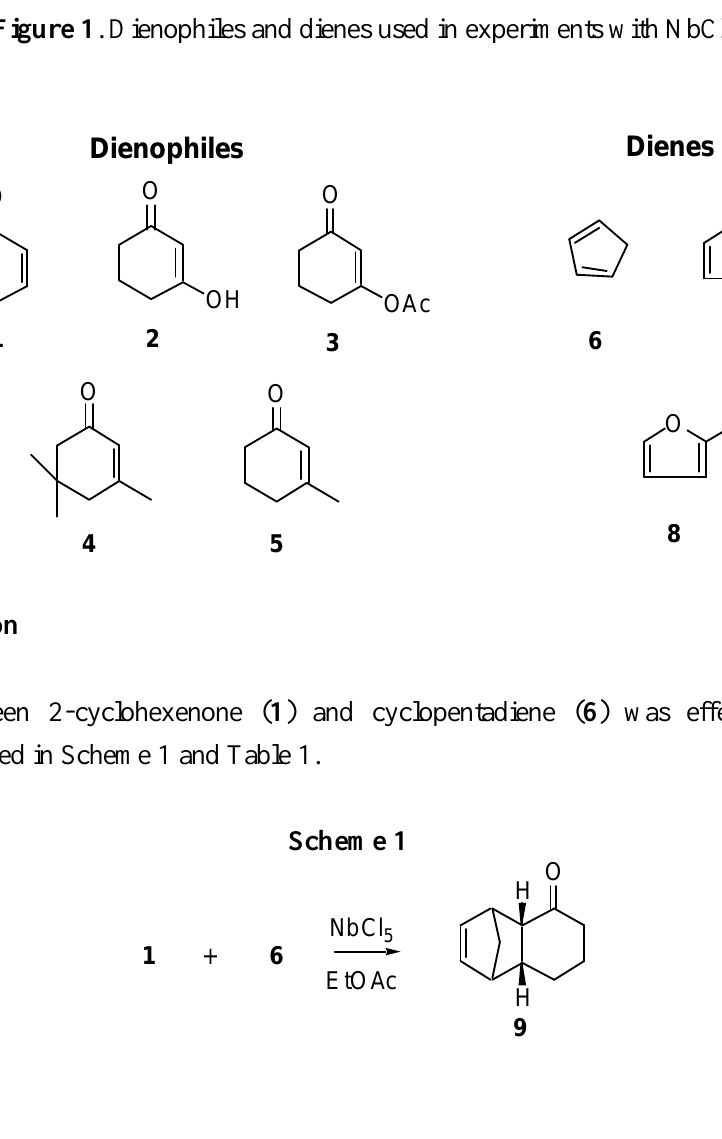
Figure 1 . Dienophiles and dienes used in experiments with NbCl